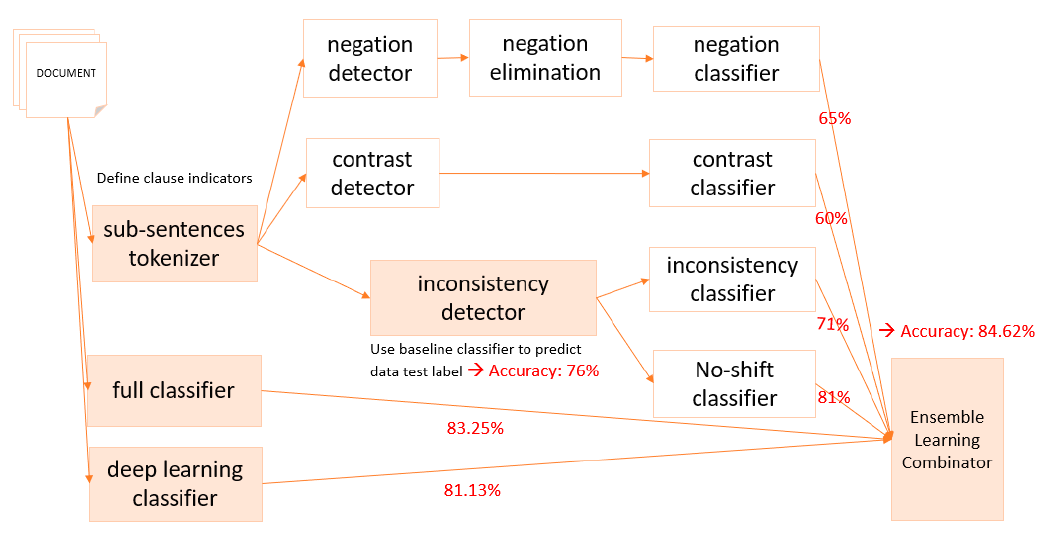
Figure 12. Average accuracy of CEM(6C-RL).